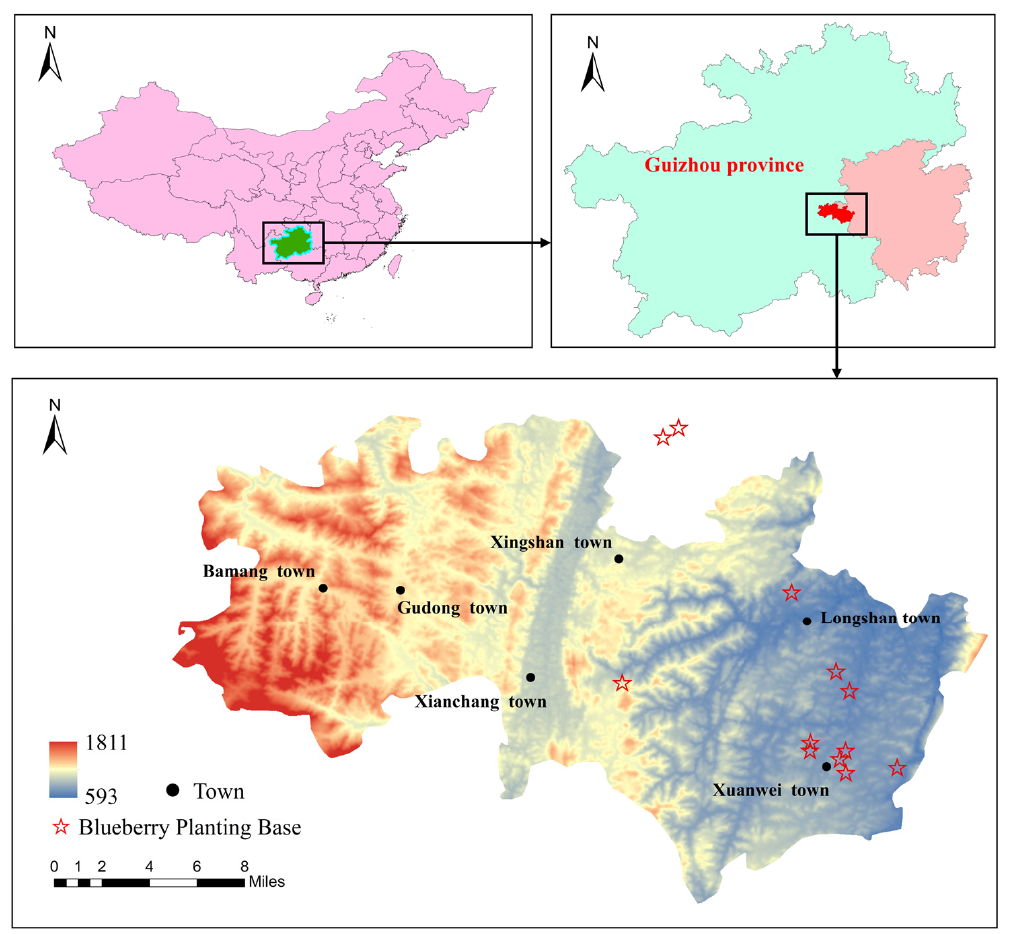
Figure 4. Overview map of the study area.